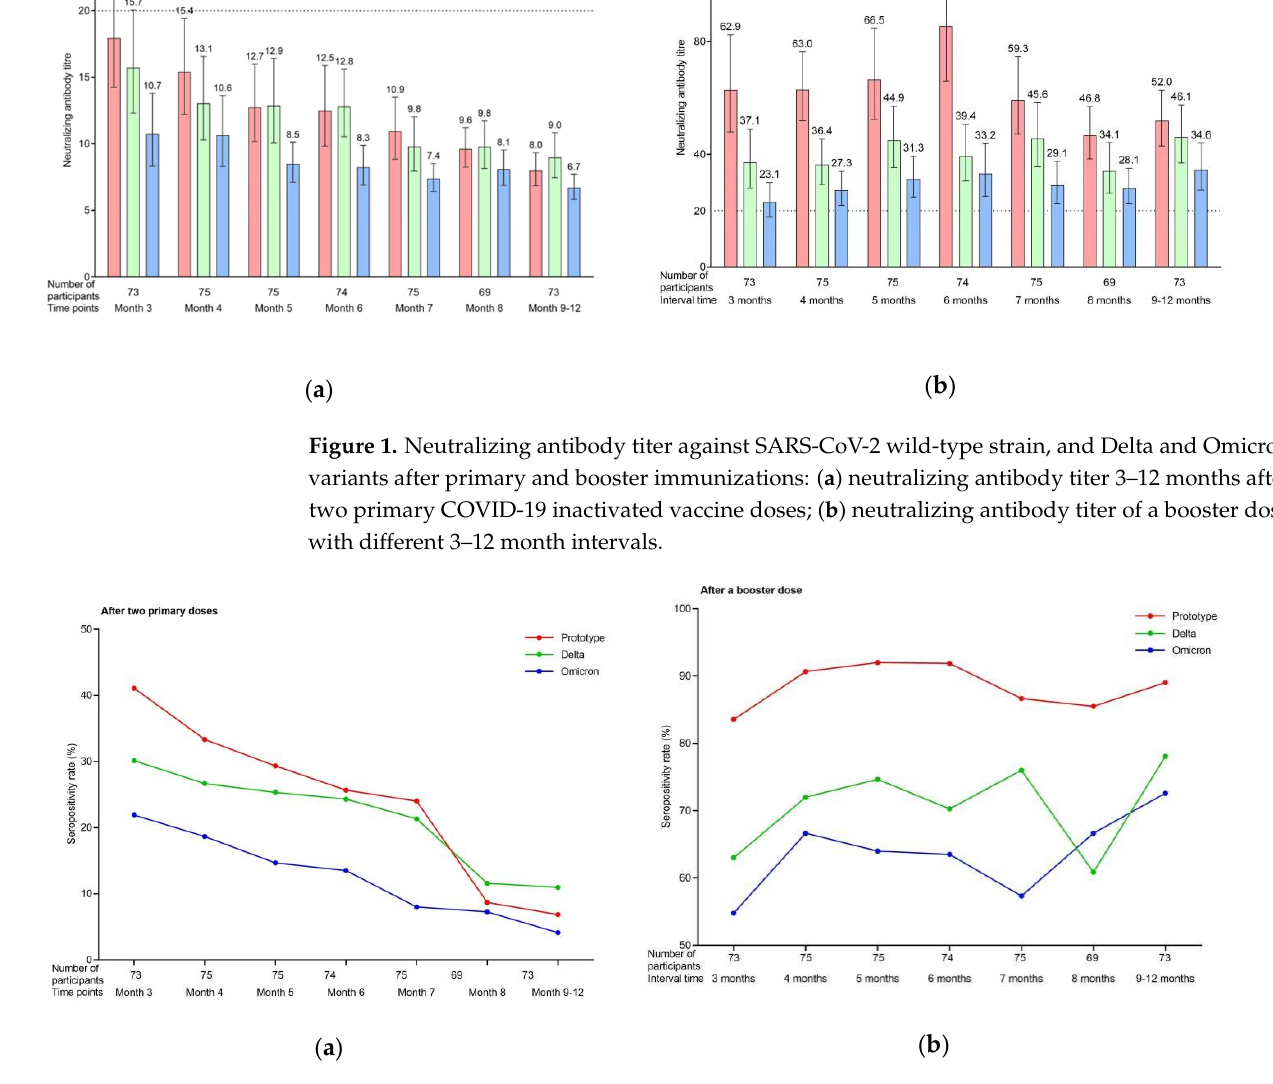
Figure 2. Seropositivity rate against SARS-CoV-2 wild-type strain, and Delta and Omicron variants after primary and booster immunizations: ( a ) seropositivity rate 3–12 months after two primary COVID-19 inactivated vaccine doses; ( b ) seropositivity rate of a booster dose with different 3–12 month intervals.